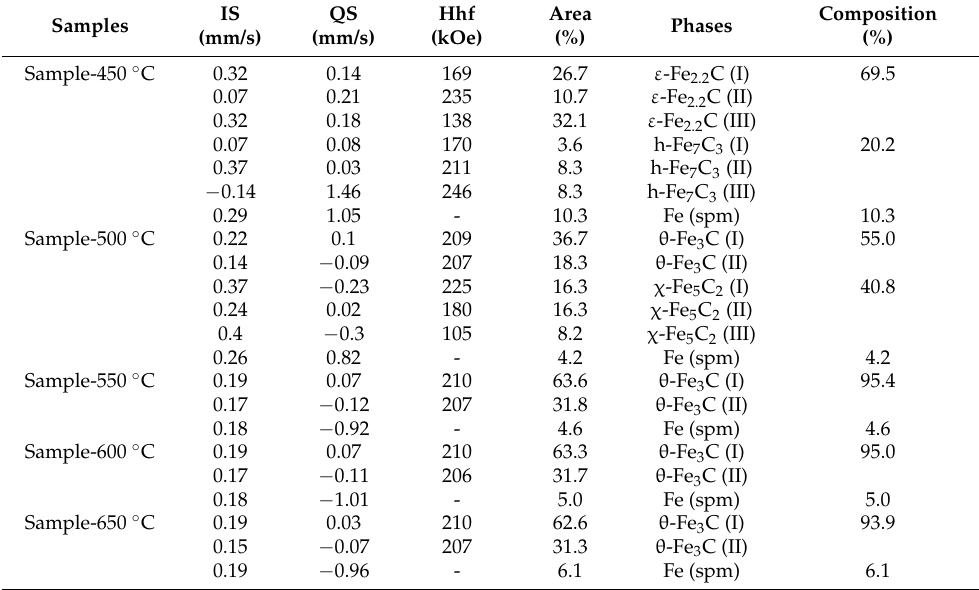
Figure 2. Phase identification of prepared samples with different pyrolysis temperatures. ( a ) XRD patterns. ( b ) MES patterns measured at room temperature. Table 2. Mössbauer parameters of the catalysts pyrolyzed at different temperatures.